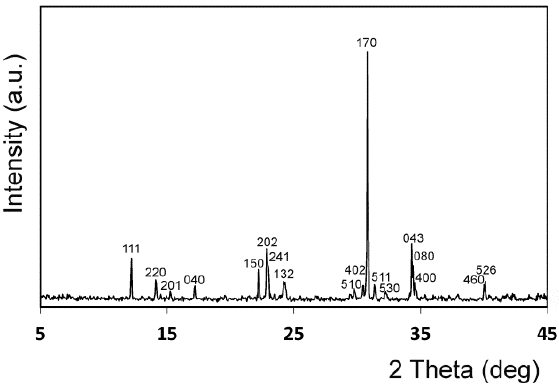
Figure 2. The X-ray diffraction (XRD) pattern of the Si- α TCP scaffolds. All peaks correspond to a high-temperature polymorph of TCP.